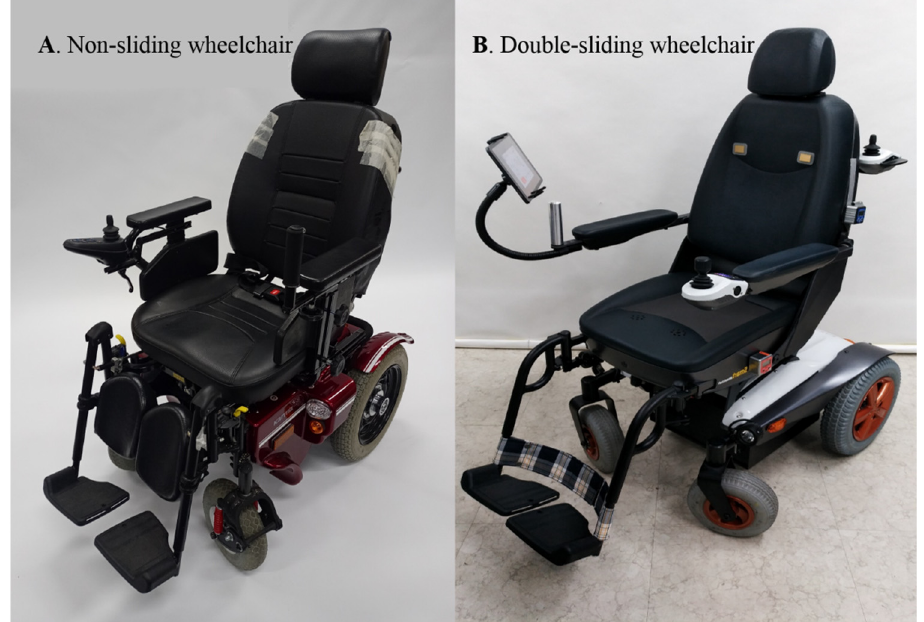
Figure 2. Two types of wheelchairs used in the experiment (( A ). Karma, ( B ). Korec).